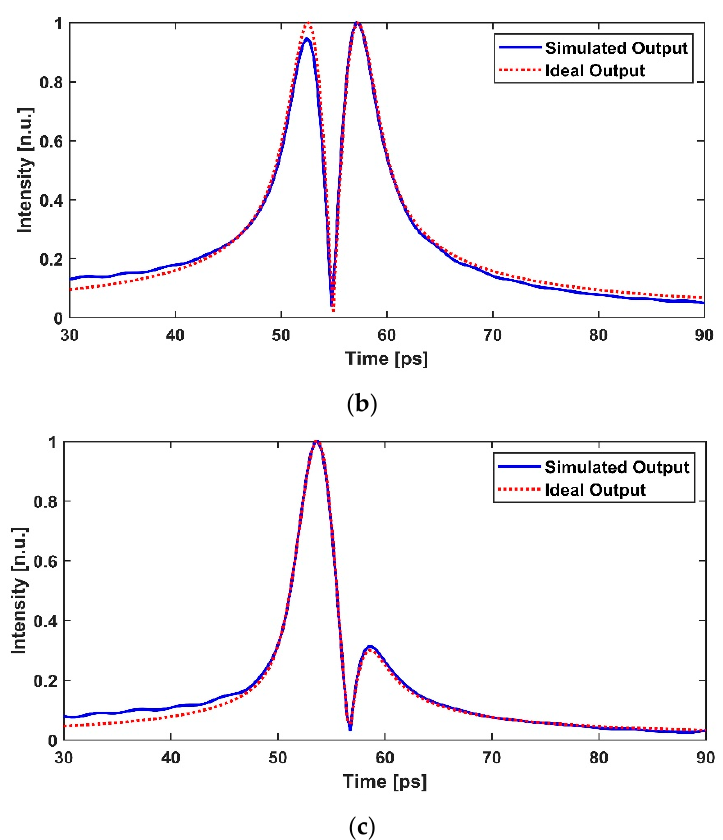
Figure 6. Comparison between the ideal (dashed red line) and simulated (blue line) output pulses for ( a ) 0.5th-order PHT; ( b ) first-order PHT; and ( c ) 1.5th-order PHT.